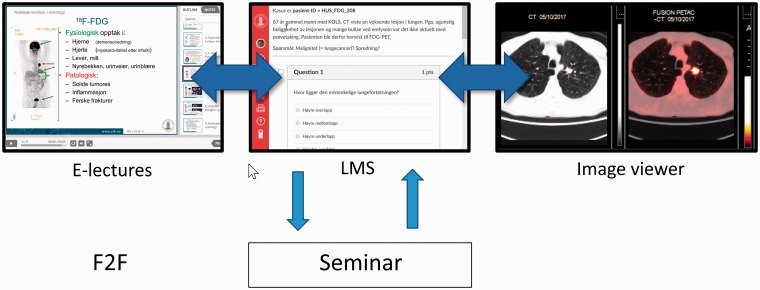
E-learning framework for teaching nuclear medicine and radiology. The e-learning framework consists of electronic lectures (e-lectures; https://www.uib.no/radionett/nuklear), a learning management system (LMS; https://mitt.uib.no) and diagnostic image viewing system. It can be extended by face-to-face (F2F) teaching as an optional component depending on the target audience.